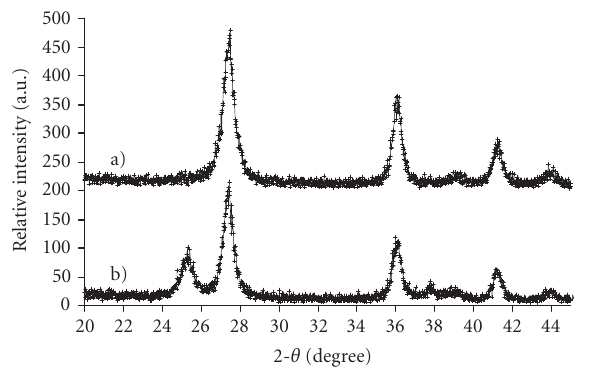
Figure 2: N 2 -physisorption curves recorded at 77K for the R100 TiO 2